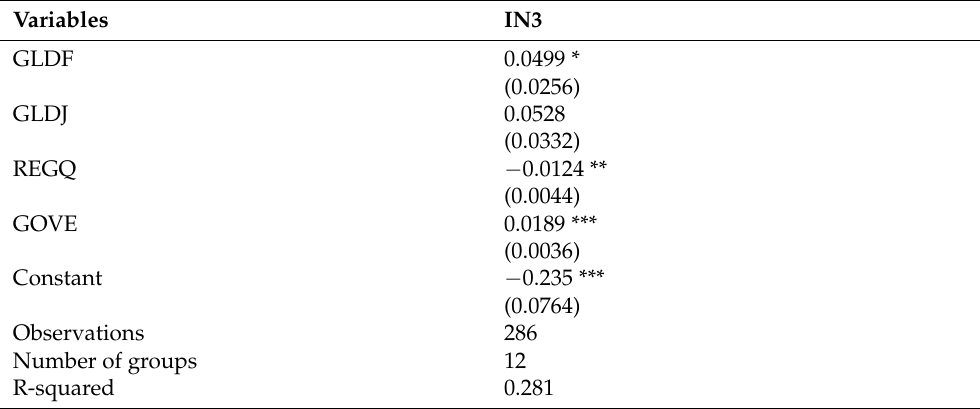
Table 14. Model 4. DV: Income Share of the Bottom 60% (IN3).